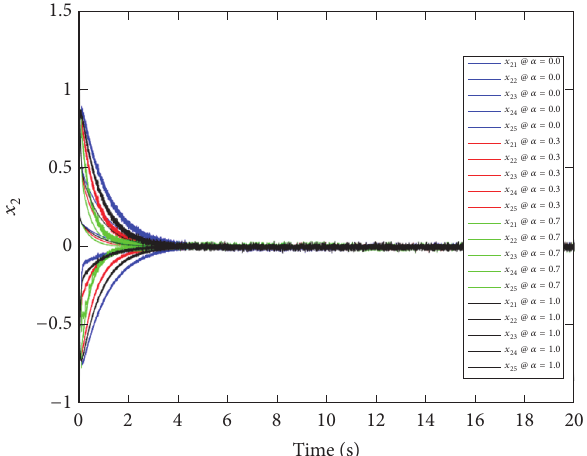
Figure 8: Gas generator state 𝑥 2 under different 𝛼 .